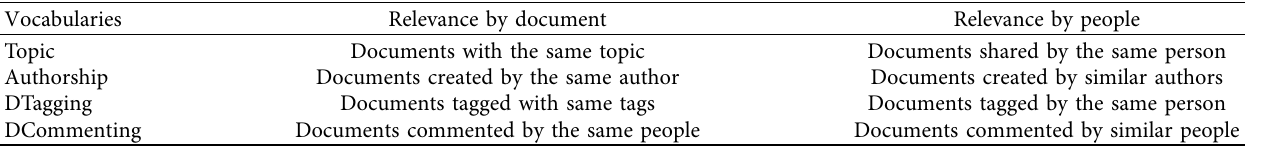
Table 2: Document-document relationships.